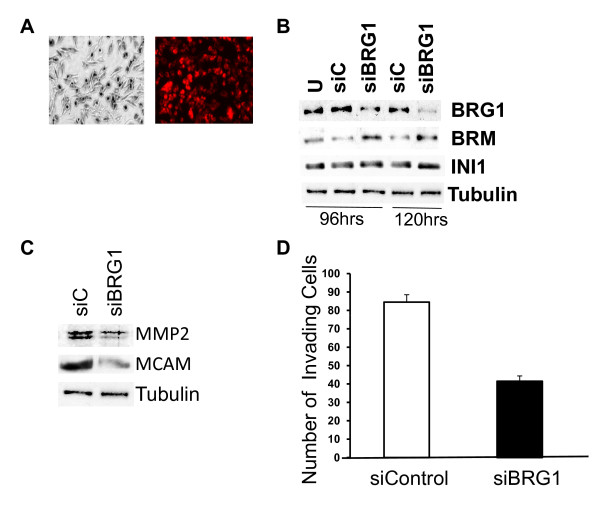
Down-regulation of BRG1 inhibits melanoma invasion through matrigel. A. WM-266-4 melanoma cells transfected with control (DY-547 labeled) siRNAs were visualized by phase-contrast microscopy. B. WM-266-4 melanoma cells were transfected with Acell SMART Pool siRNAs targeting BRG1 or red non-targeting siRNAs and analyzed by Western blotting. C. Control and BRG1 down-regulated WM-266-4 cells were subjected to the invasion assay as described in Figure. 5, 120 hours after transfection with siRNAs. Invasion was significantly compromised in BRG1 down-regulated cells (p < 0.01).